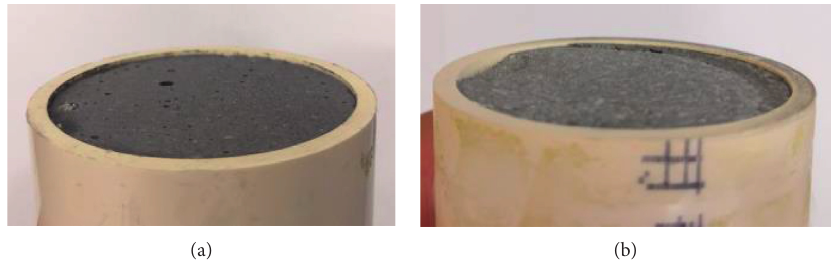
Figure 9: End faces of specimens after triaxial loading. (a) P-UM. (b)